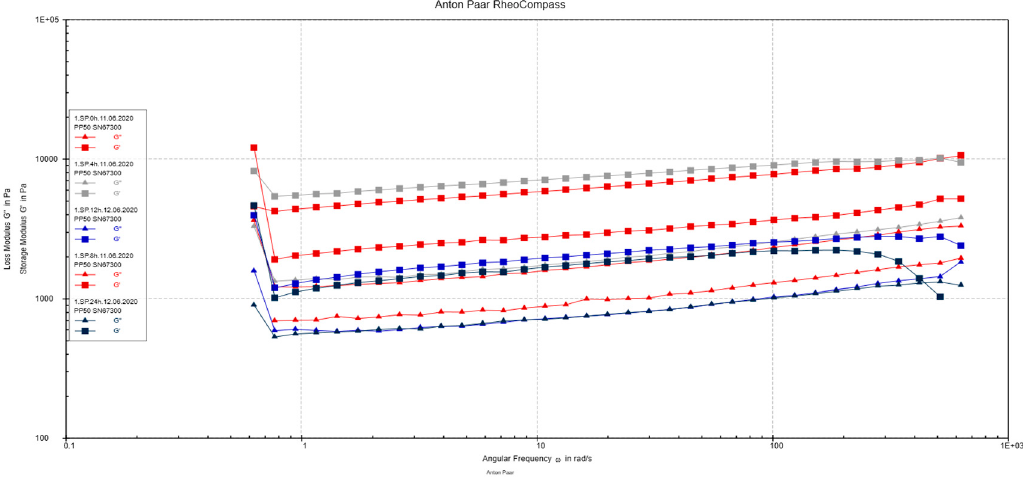
Figure 4. The storage (G’) and loss (G”) shear moduli for SP sourdough at different fermentation times: 0, 4, 8, 12, and 24 h.